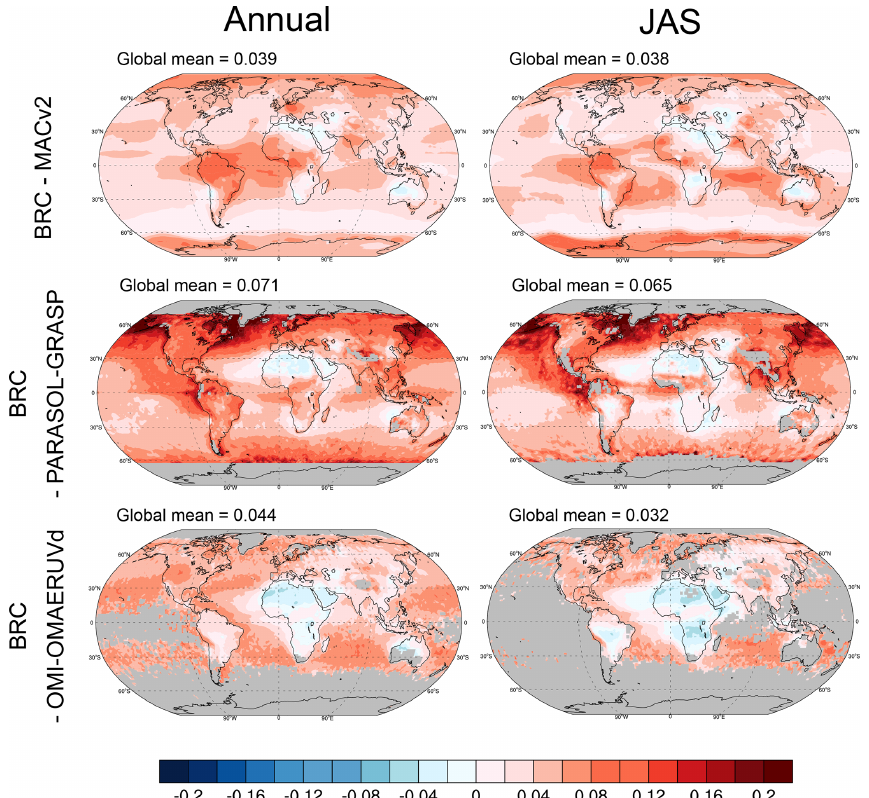
Figure A4. SSA (440nm; see Tables 2 and 3 for details) difference between the BRC simulation and MACv2, PARASOL-GRASP, and OMI-OMAERUVd averaged over the year and over JAS. Shaded areas indicate a missing value.